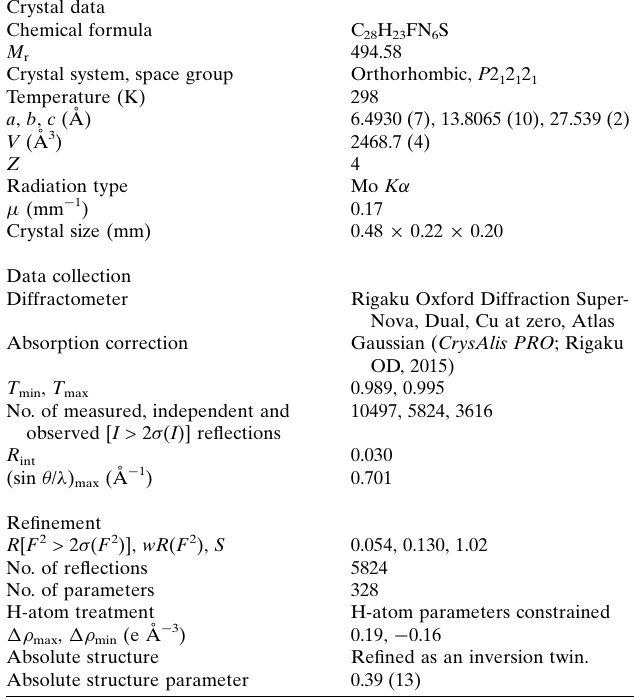
Table 2 Experimental details.